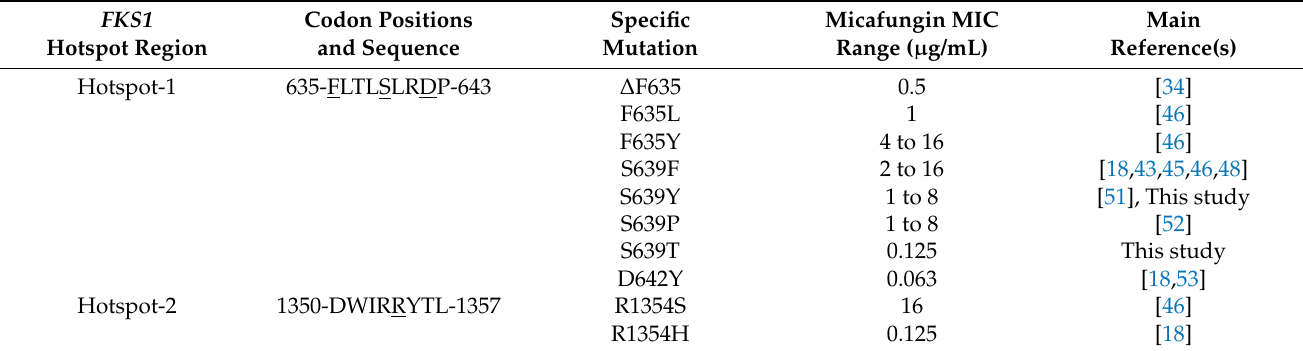
Table 2. Non-synonymous or deletion mutations detected in hotspot-1 and hotspot-2 of FKS1 in C. auris reported in different